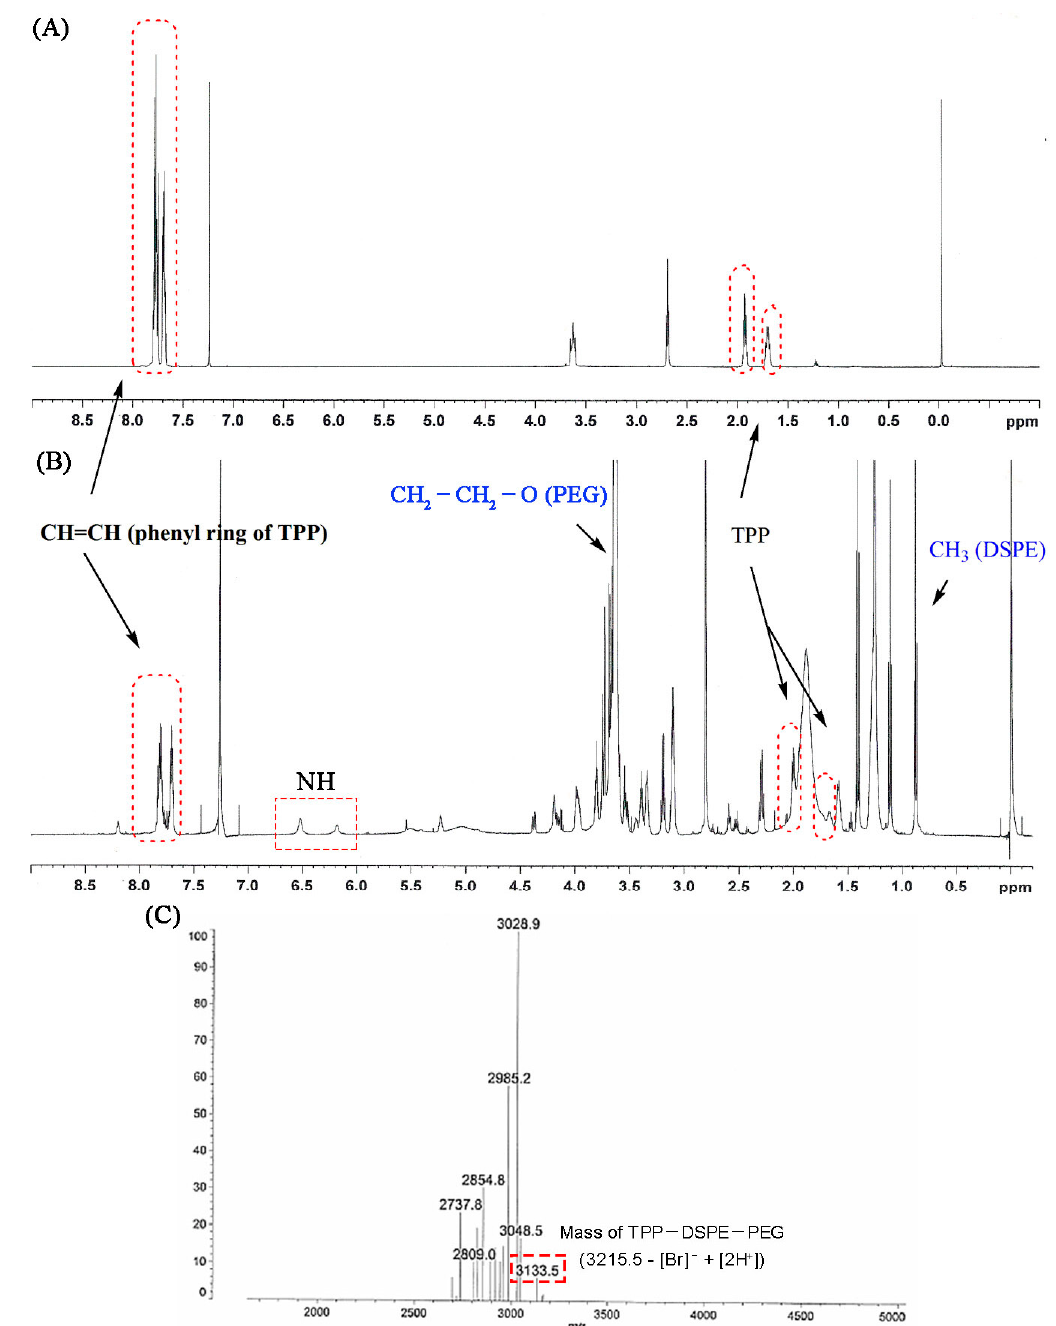
Figure 3. Proton NMR spectra of carboxybutyl triphenylphosphonium bromide (TPP) ( A ) and TPP-DSPE-PEG conjugate ( B ). ( C ) MALDI-TOF mass of TPP-DSPE-PEG.